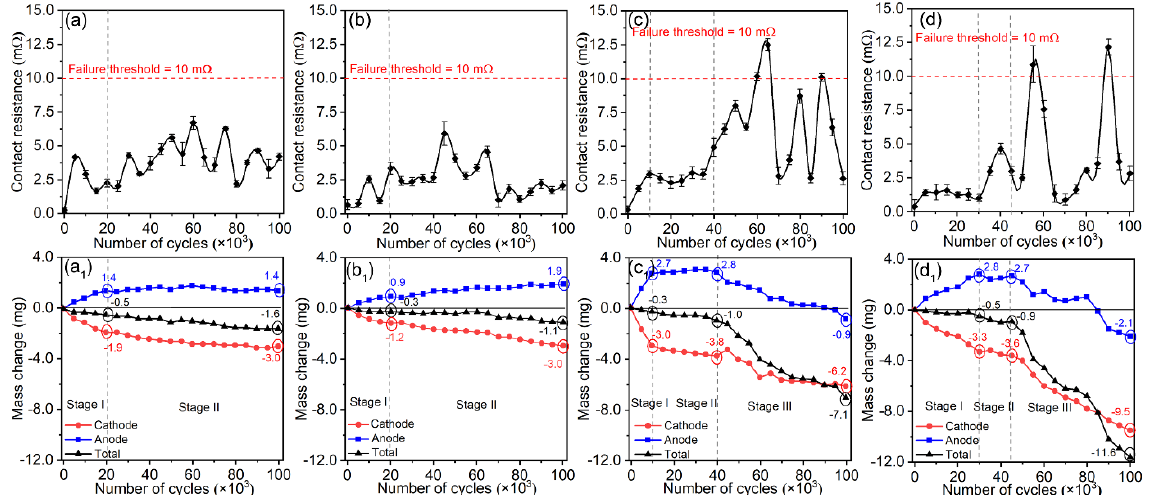
Figure 5. The change in contact resistance ( a – d ) and mass ( a 1 – d 1 ) as the cycle number of contact tests increased. The mean size of Y 2 O 3 used: ( a , a 1 ) 243 nm, ( b , b 1 ) 387 nm, ( c , c 1 ) 792 nm, ( d , d 1 ) 980 nm.